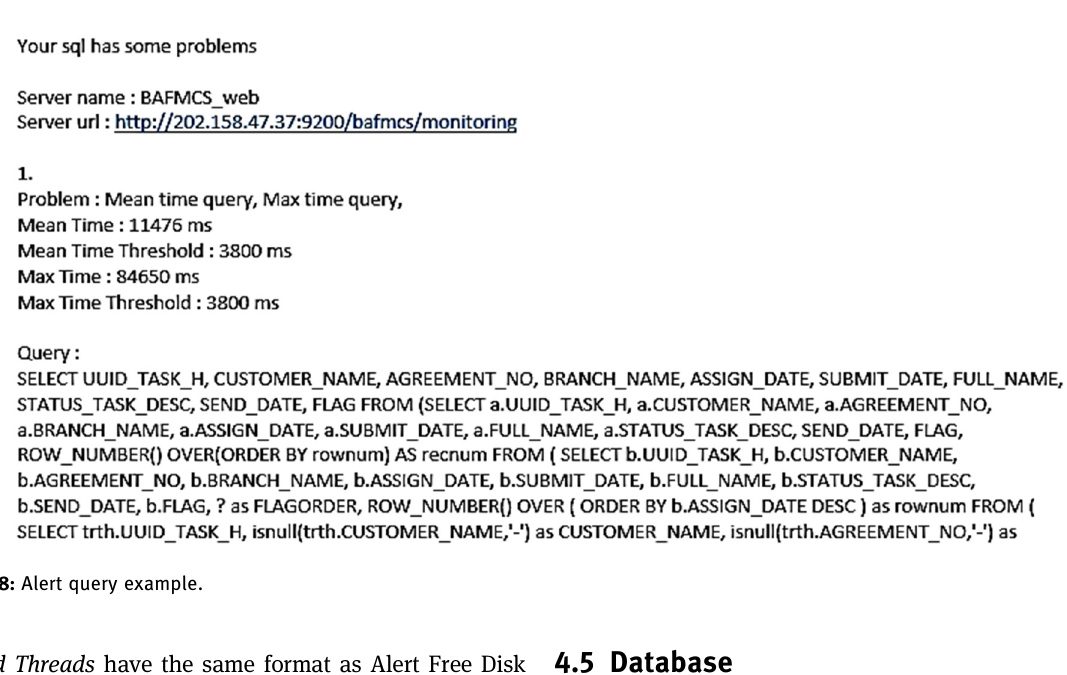
Figure 8: Alert query example.